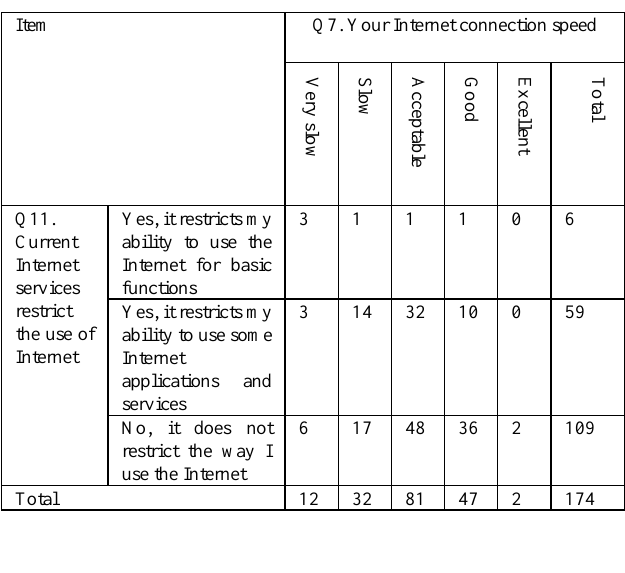
Table 2. Internet service restrictions versus connection speed